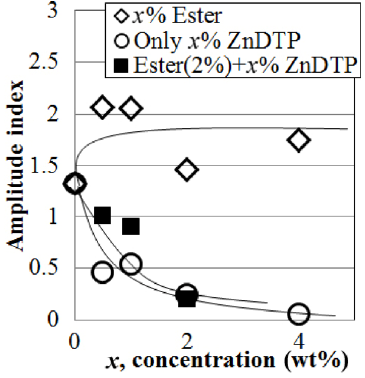
Fig. 9 Correlation between additive concentration and amplitude index (AI).